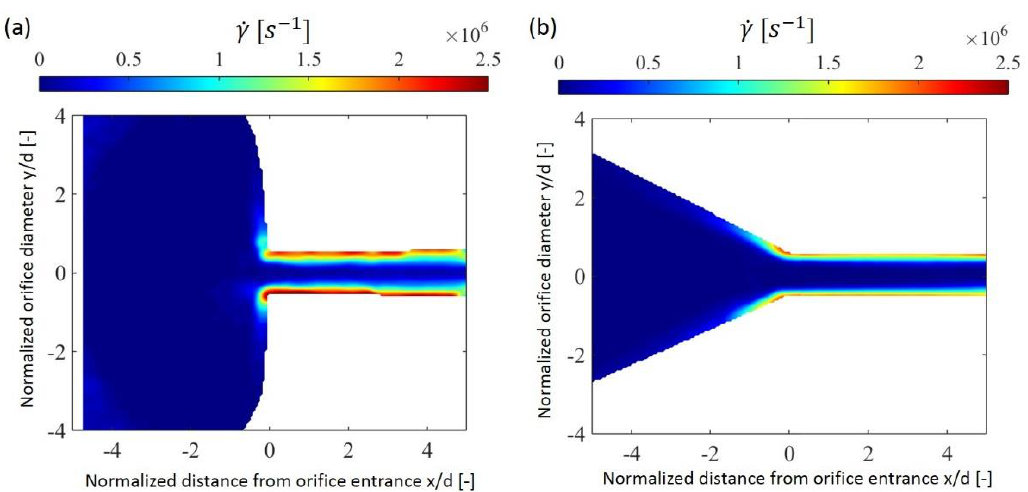
Figure 1. Shear stresses 𝛾̇ in an optically accessible orifice with a conical ( a ) and sharp-edge ( b ) inlet geometry. The Figure was taken from Bisten et al. [6].